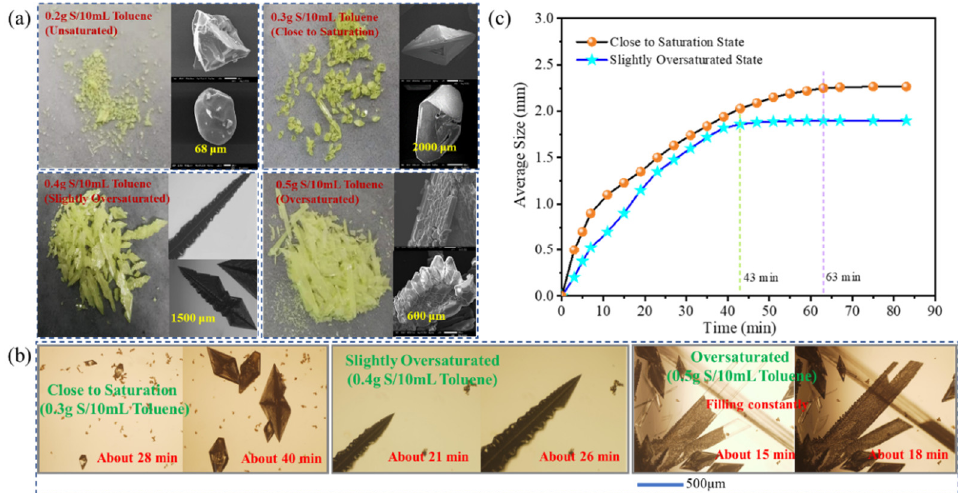
Figure 2. Photos and corresponding SEM images of sulfur crystals with different saturations pre- cipitated in toluene ( a ), optical microscope photos of sulfur precipitation in toluene with different saturations ( b ) and growth rate curves of samples in slightly oversaturated and close to saturated state ( c ).